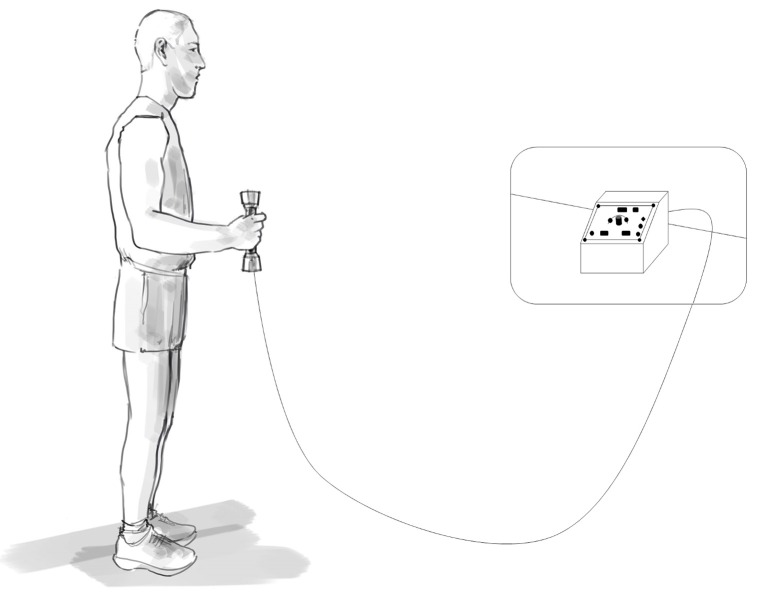
Schematic sketch of the subject's posture for maximal isometric voluntary contraction and vibration interventions.